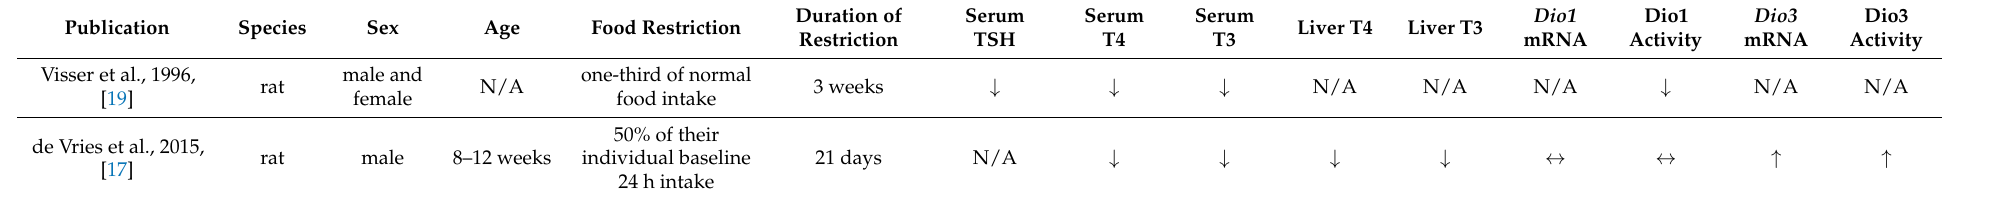
Table 2. Regulation of the TH system upon food restriction. N/A: not available, ↔ : no change, ↓ : lower than control, ↑ : higher than